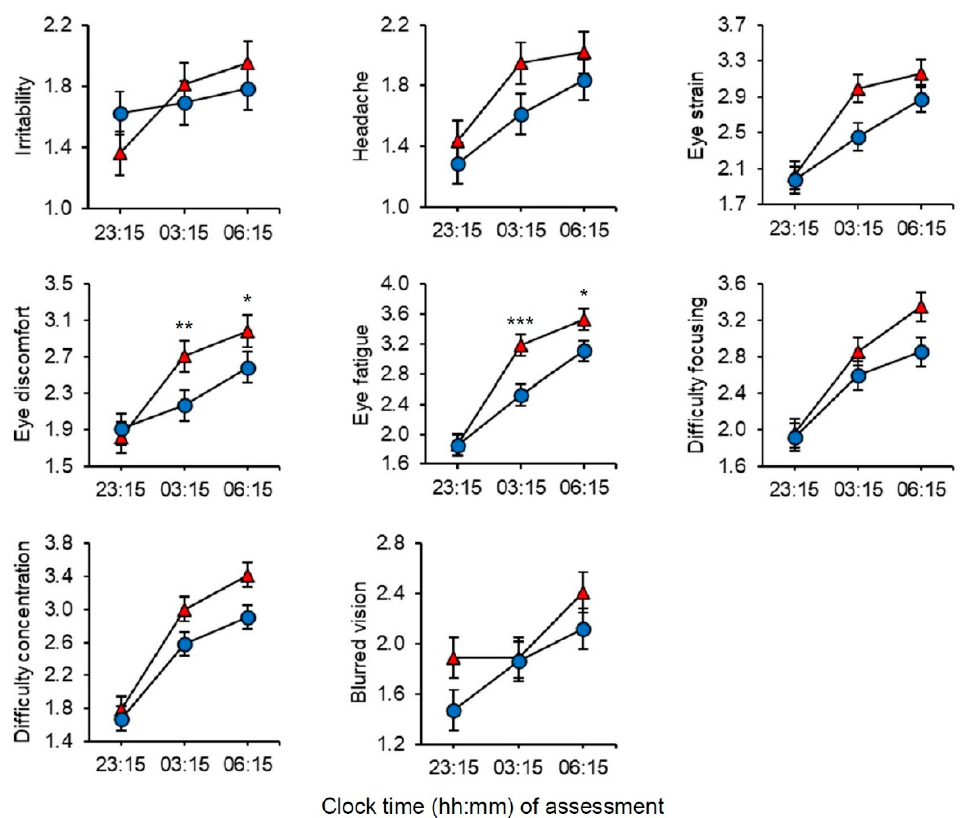
Figure 4. Visual comfort assessed with the headache and eye strain scale (1–4 (severe)) during a simulated night shift in long-wavelength narrow-bandwidth light (triangles) and short-wavelength narrow-bandwidth light (circles). Data points are the estimated marginal means with error bars indicating standard error. Significant differences between light conditions indicated for variables with a significant Light by Time interaction only. * = p < 0.05, ** = p < 0.01, *** = p < 0.001.